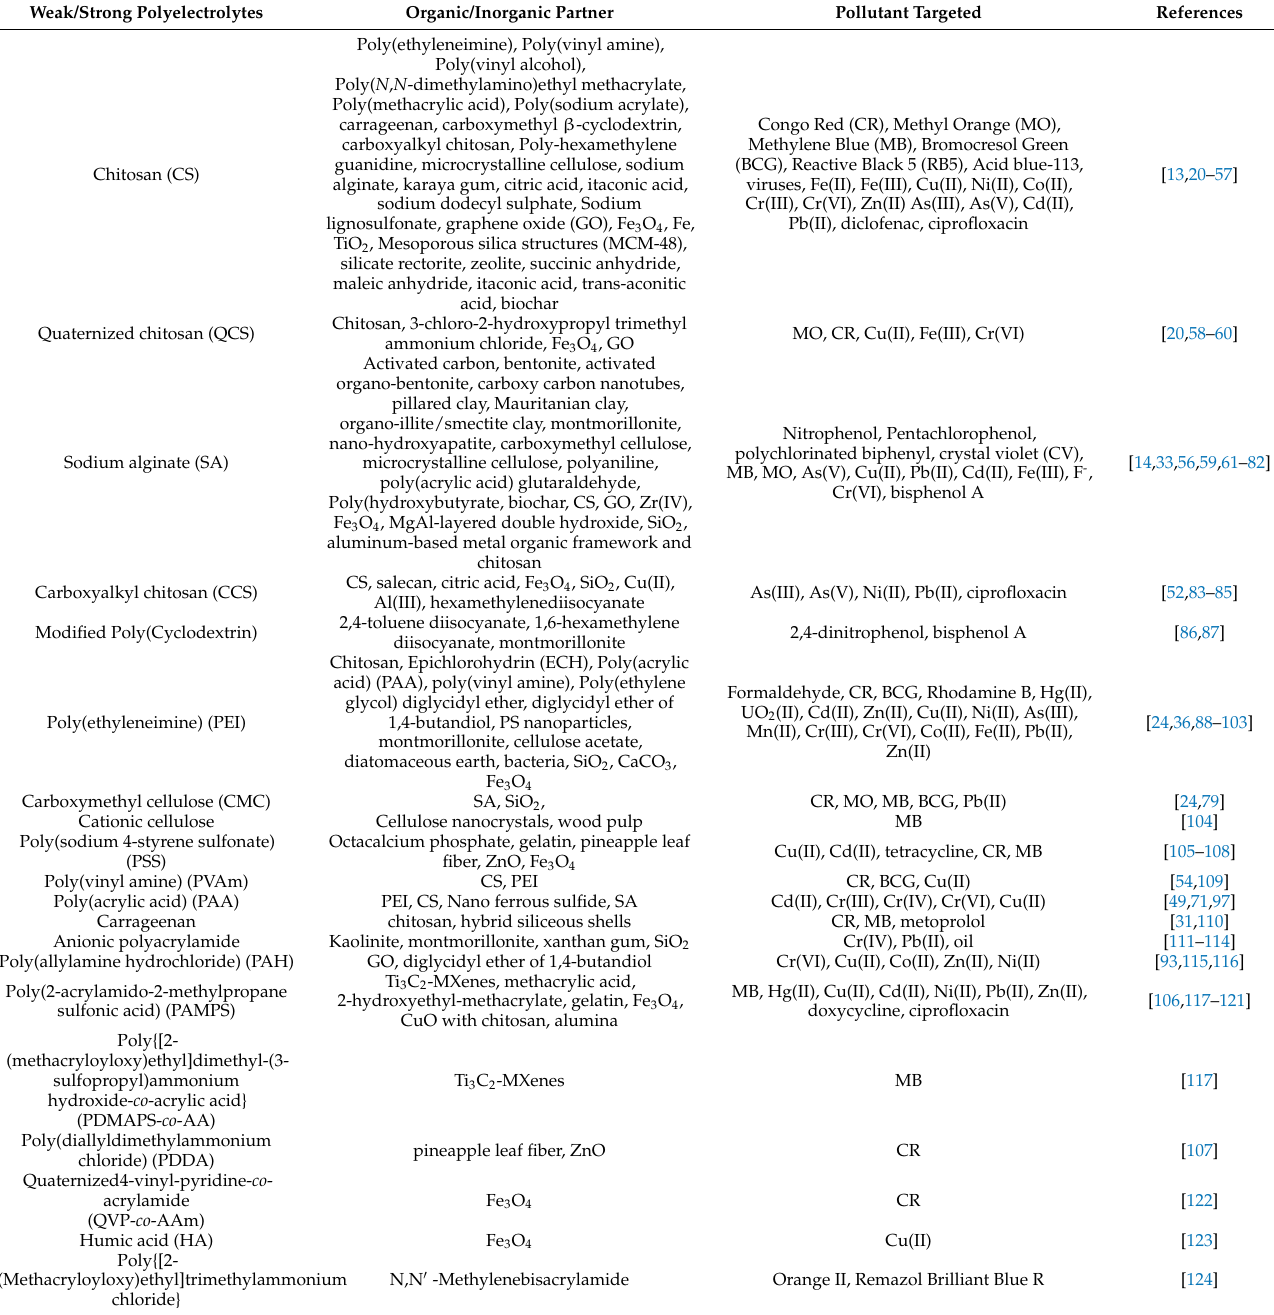
Table 1. Composite sorbents based on polyelectrolytes used for pollutants removal from aqueous media. Weak/Strong Polyelectrolytes Organic/Inorganic